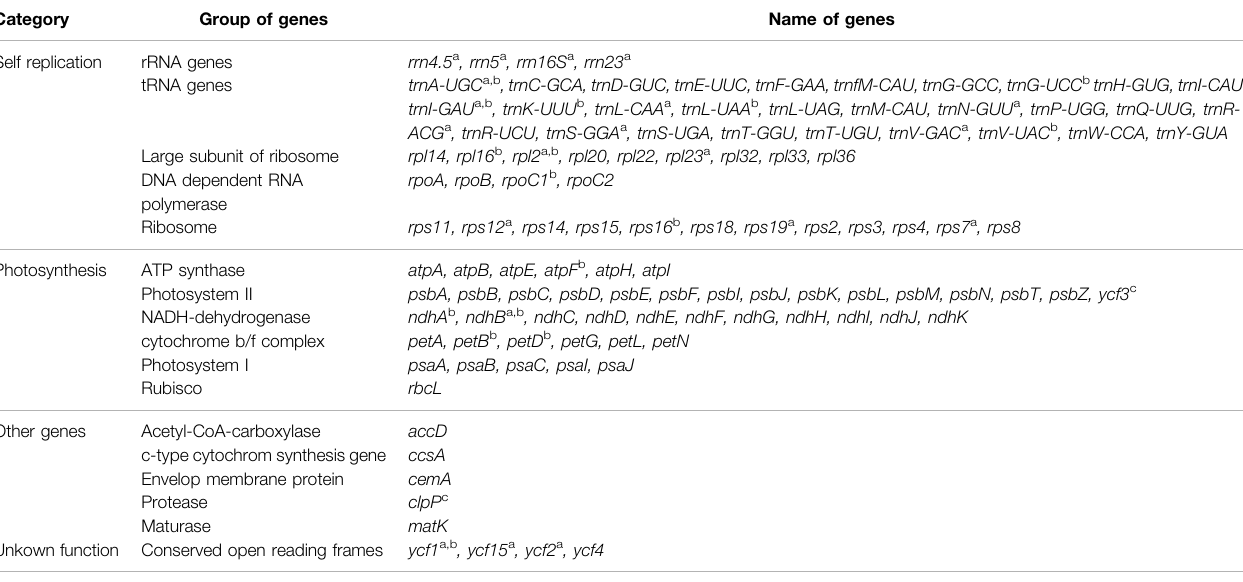
TABLE 1 | Gene list of cp genome in A. ukurunduense